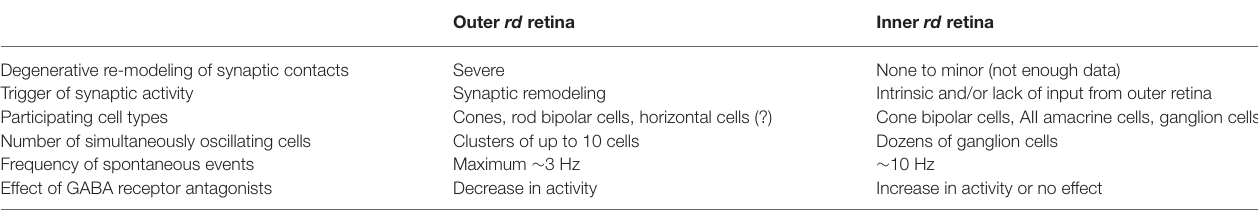
TABLE 1 | Differences between outer and inner oscillatory activity in the rd retina (for detailed information, see